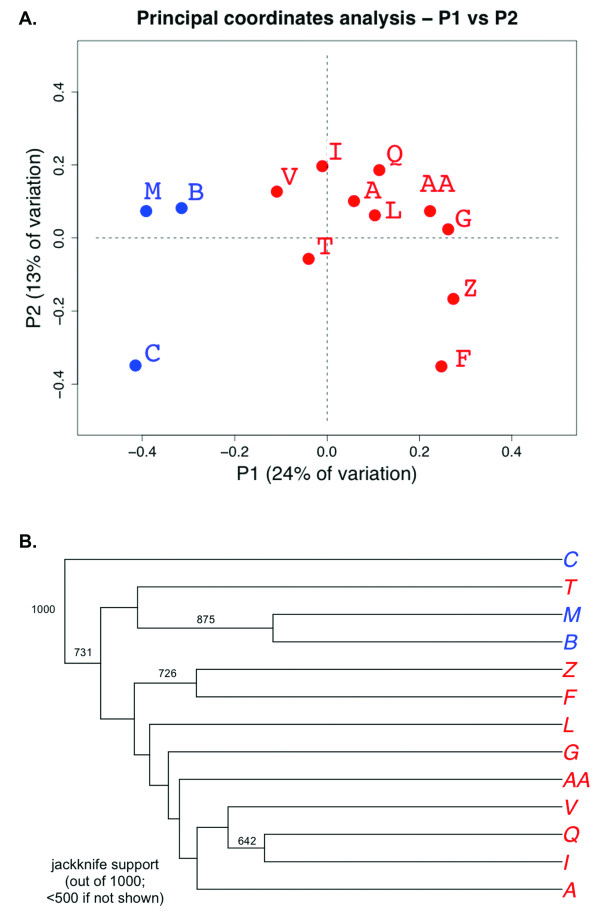
Statistical analyses of bacterial populations in low and high disease plaque. A) Principal coordinate analysis of bacterial communities from subgingival plaque of West Virginians with low oral disease (blue) as compared to plaque of West Virginians with varying degrees of oral disease (red). B) The Unifrac algorithm was used to compute the unique branch length for a given sub-sample. Cluster analysis split low (blue) and diseased samples (red) into different clades. Support for the clusters was evaluated by jackknife tests (1000 replicates). T was the least diseased sample in the Cognitive study, as ranked in Table 2. The 'D' has been removed from sample notations in these figures for clarity.